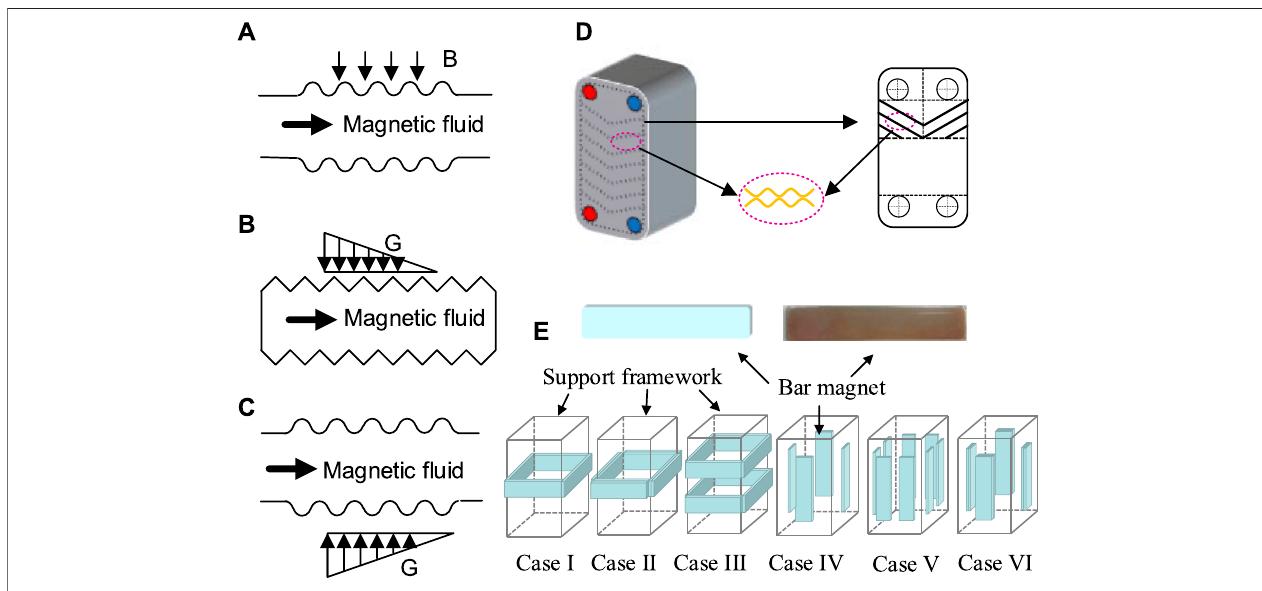
FIGURE 10 | (A) A wavy channel with a magnetic fi eld (Heidary et al., 2017), (B) a triangular corrugated channel and arrangements of magnetic fi eld gradients (Aminfar et al.,2014), (C) awavy channelwith agradient magnetic fi eld(Mousavi et al.,2020), (D) schematic diagram ofaheatexchanger withcorrugatedplates (Zheng et al., 2020b), and (E) schematic diagram of six arrangements of magnets (Zheng et al.,